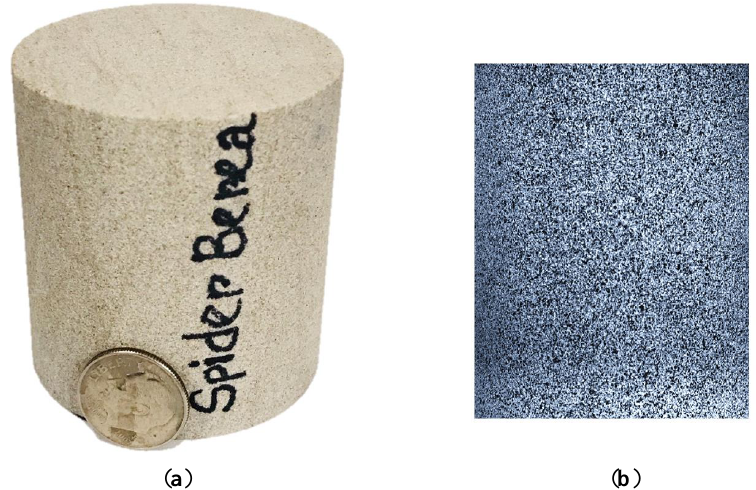
Figure 1. Sample preparation for uniaxial compression testing. ( a ) Sample for uniaxial compression testing; ( b ) painted side of the sample.